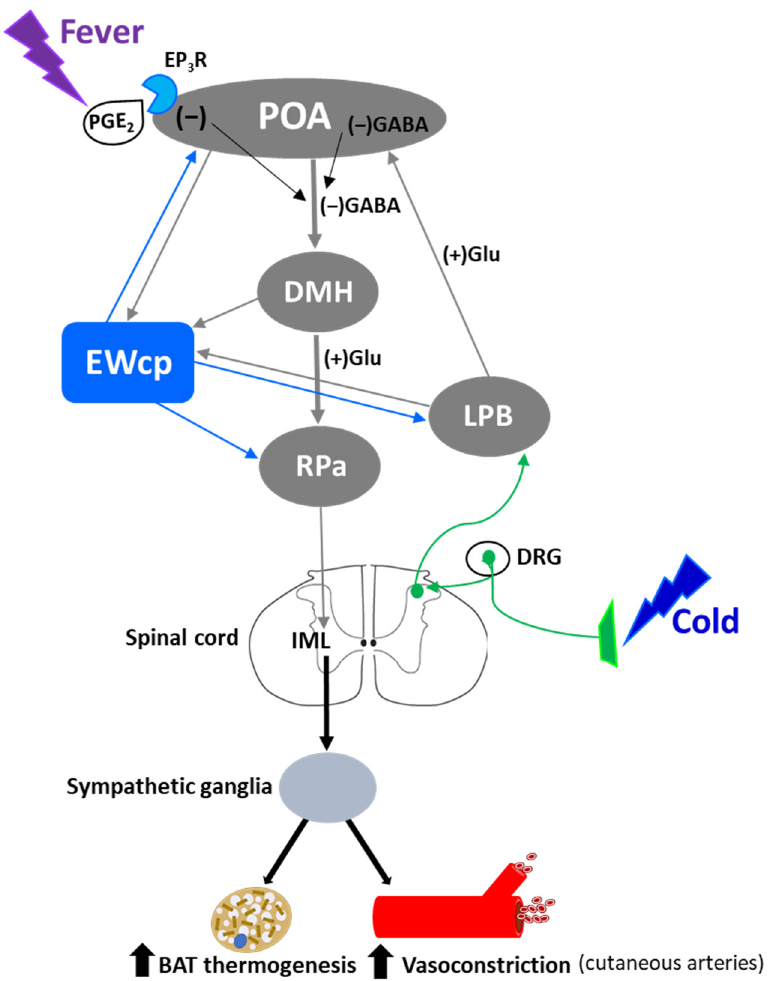
Figure 8. Connections of EWcp with circuits involved in non-shivering thermogenesis and fever. Inhibition of preoptic inputs to DMH, either by excitation from LPB (cold) or by prostaglandin activation of EP 3 R (fever), causes disinhibition of a sympathoexcitatory pathway mediated by DMH and RPa. EWcp receives projections from the main elements involved in these pathways (POA, DMH and LPB), and projects to presympathetic regions that are key elements for the output signal, including RPa. Increased sympathetic outflow to BAT and blood vessels (especially the tail artery in rodents) evokes augmented thermogenesis and vasoconstriction, respectively. Abbreviations: DRG, dorsal root ganglion; EP 3 R, prostaglandin EP3 receptors; LPB, lateral parabrachial nucleus; PGE 2 , prostaglandin E. For the rest of the terms, see the list of